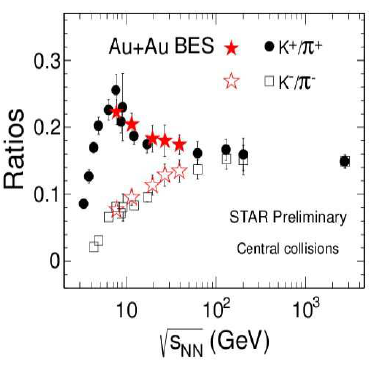
Figure 1. Energy dependence of K ± /π ± ratio for central heavy ion collisions at